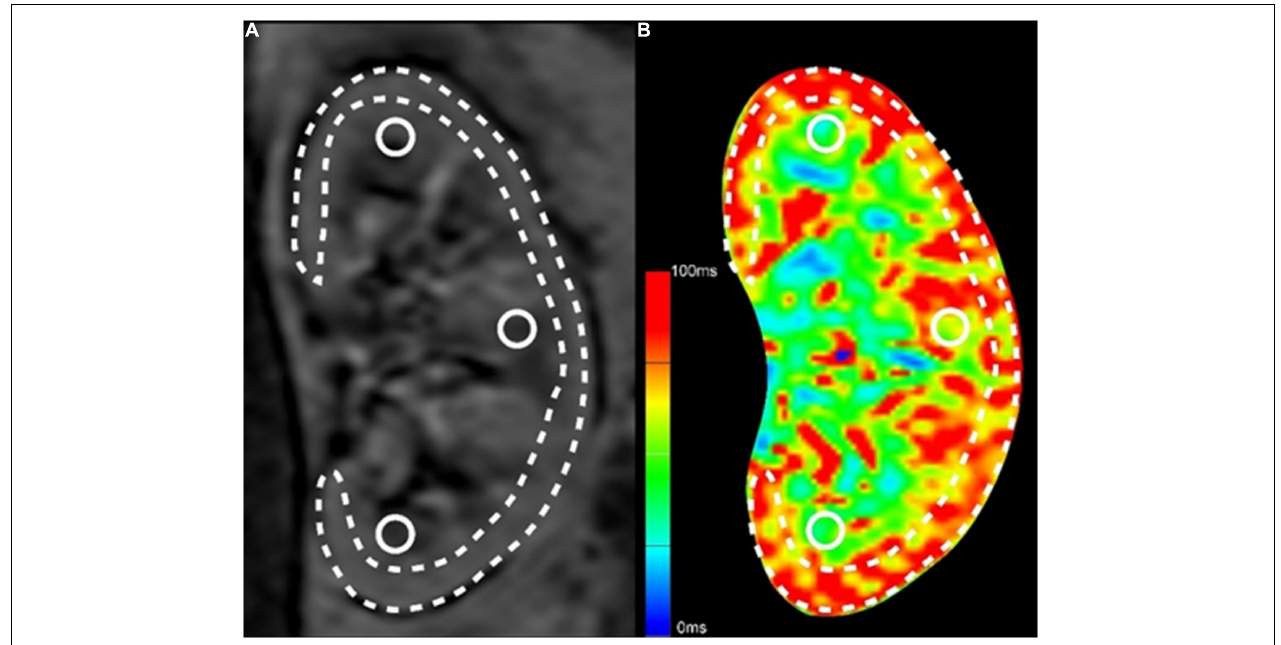
FIGURE 1 | Methods for ROI selection on BOLD-MRI images. (A) The original T2*-weighted image; (B) The pseudo-color T2*-weighted image. The long and narrow area depicted by the dashed line was the ROI of renal cortex, excluding the renal medulla, collecting system, incidental cysts, and hilar vessels. The three circular areas on the upper, middle and lower medulla of the kidney were the ROIs of the medulla.